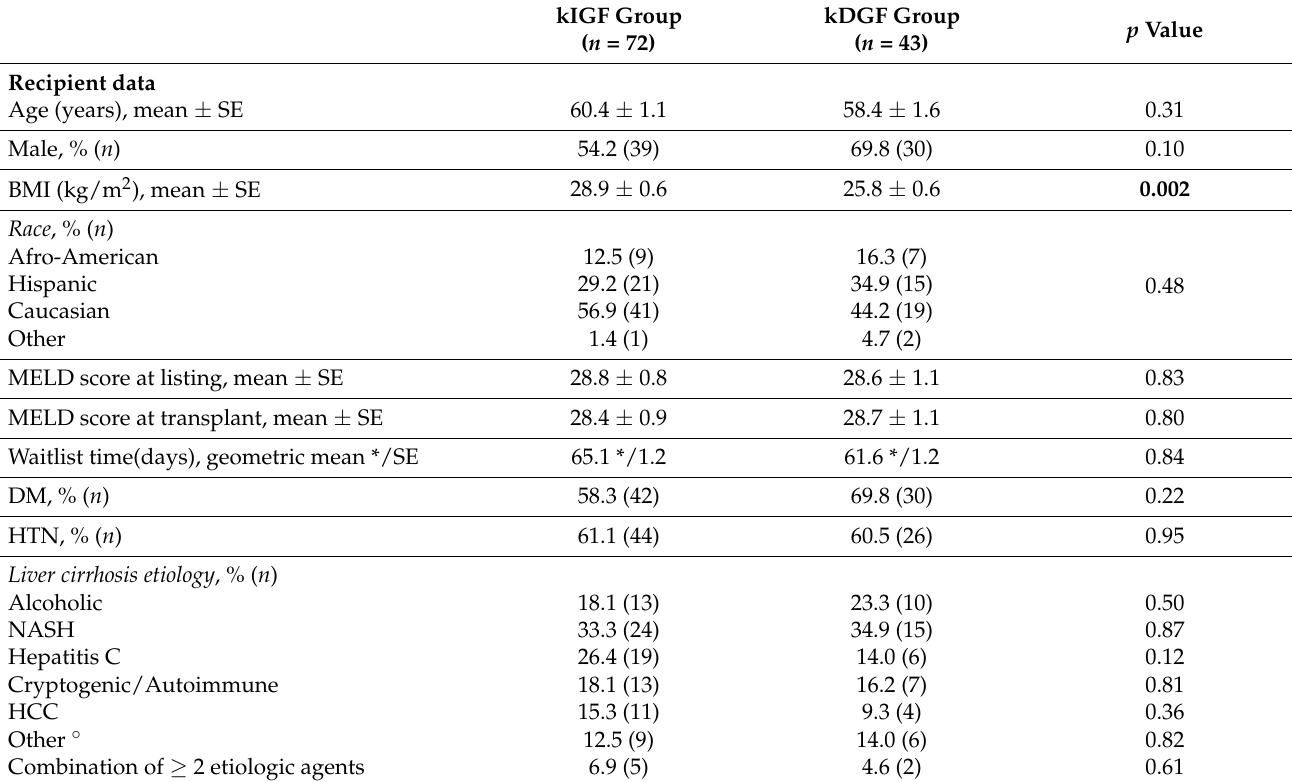
Table 1. Comparisons of preoperative recipient variables by group (kIGF vs. kDGF) 1 . kIGF